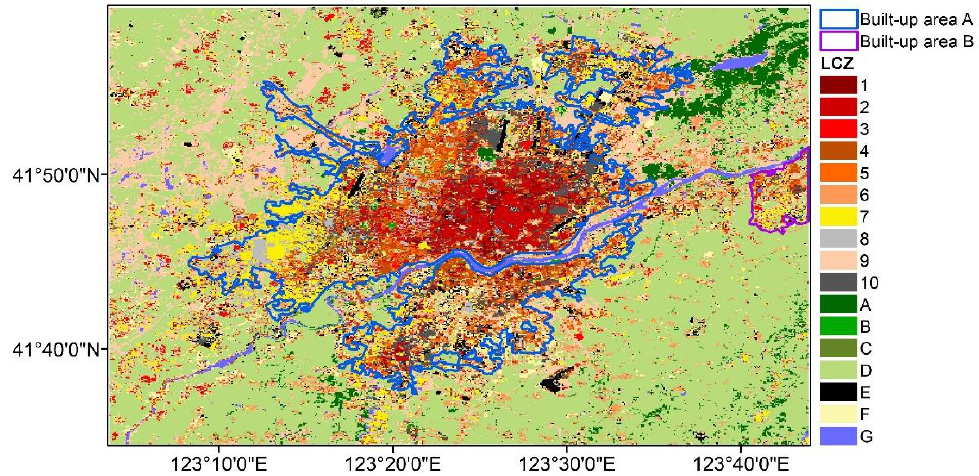
Figure 2. Distribution of local climate zones in the study area. Table 2. The area of different LCZ types in the study area, built-up area and rural areas.